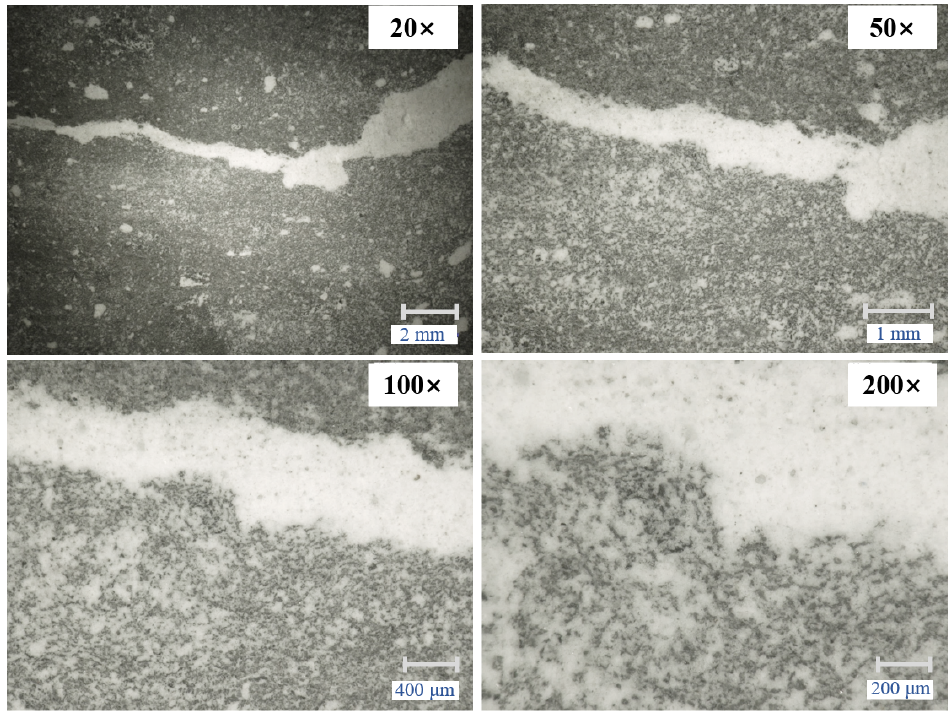
Figure 6. The surface of a brick cube with natural cracks restored by MICP at magnifications of 20×,